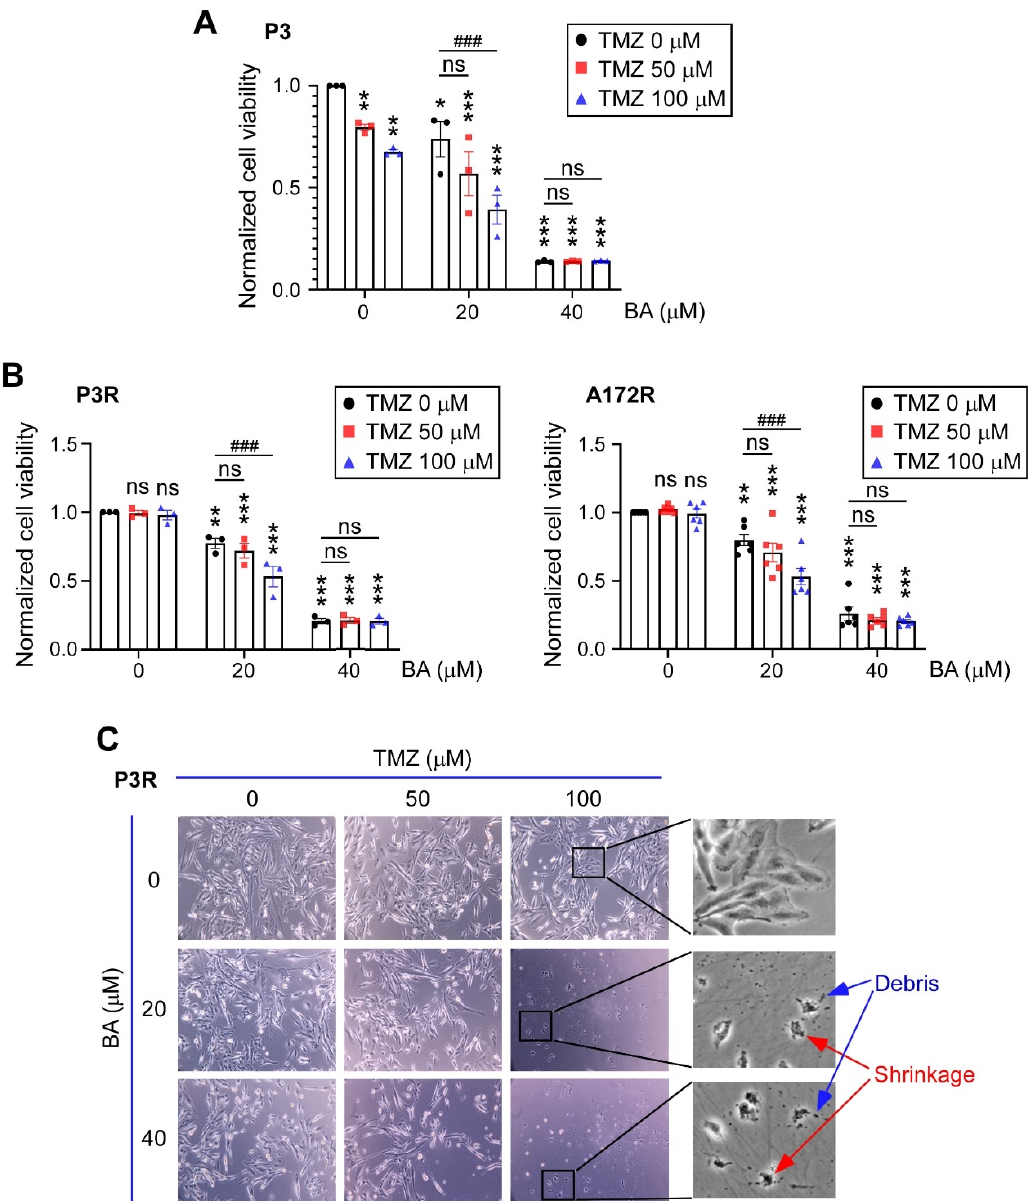
Figure 2. BA enhances TMZ antitumor effects in malignant GBM cells. ( A ) TMZ-sensitive P3, ( B ) TMZ-resistant P3R/A172R, and TMZ-resistant P5R GBM cells were treated with TMZ and/or BA at indicated concentrations for 2 days. ( A , B ) Cell viability of P3, P3R, and A172R cells determined by MTT assay. Data presented as means ± standard deviations (t-Test: * p < 0.05, ** p < 0.01, and *** p < 0.005 vs nontreatment control; ### p < 0.005 vs TMZ-alone group; ns: not significant). ( C ) Representative images of P3R cells (original magnifications ×100 [left panels] and ×400 [right panels]).